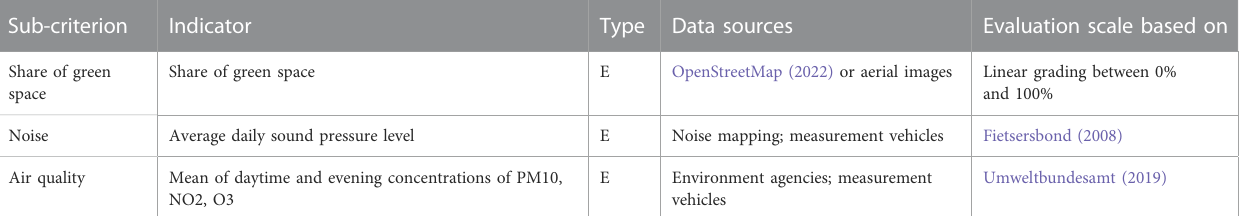
TABLE 6 Attractiveness: sub-criteria, indicators, type of indicators (E: edge-based, R: route-based, N: network-based), data sources and sources for evaluation scales.